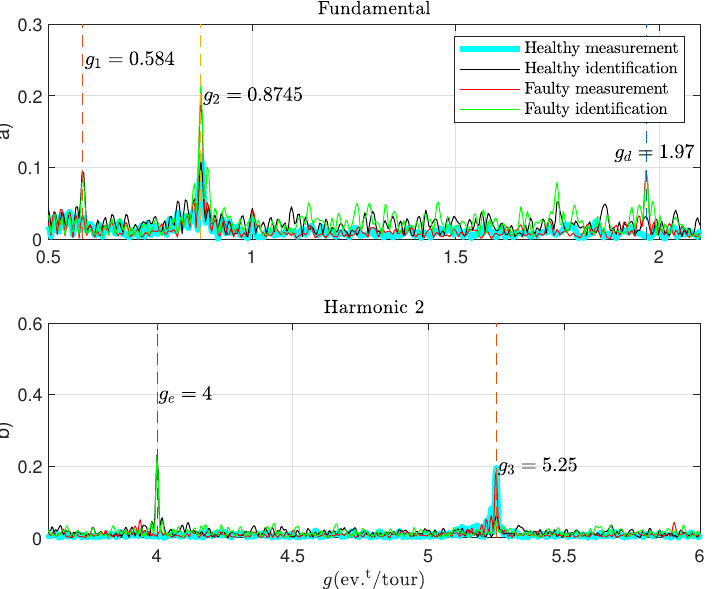
Figure 10. Angular spectrum of mechanical frequency. ( a ) between 0.5 and 2 ev. t /rev, ( b ) between 0 and 6 ev. t /rev.